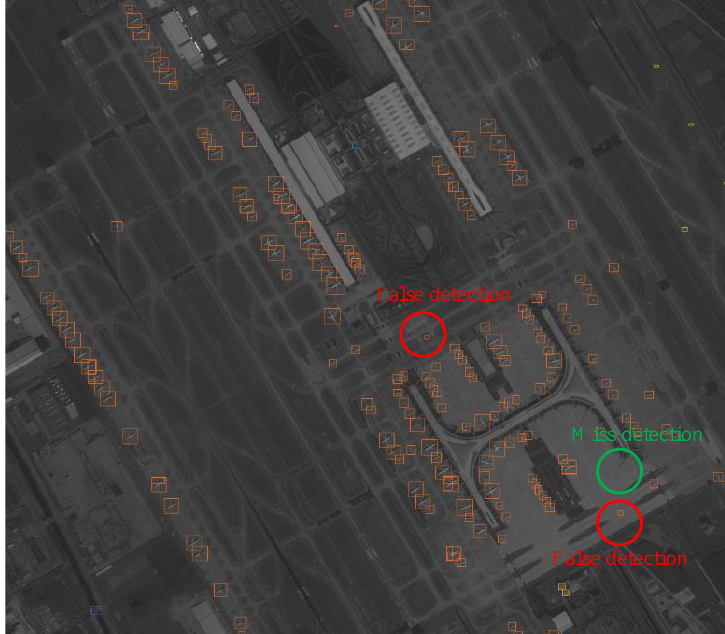
Figure 20. Detection results based on the compressed image.